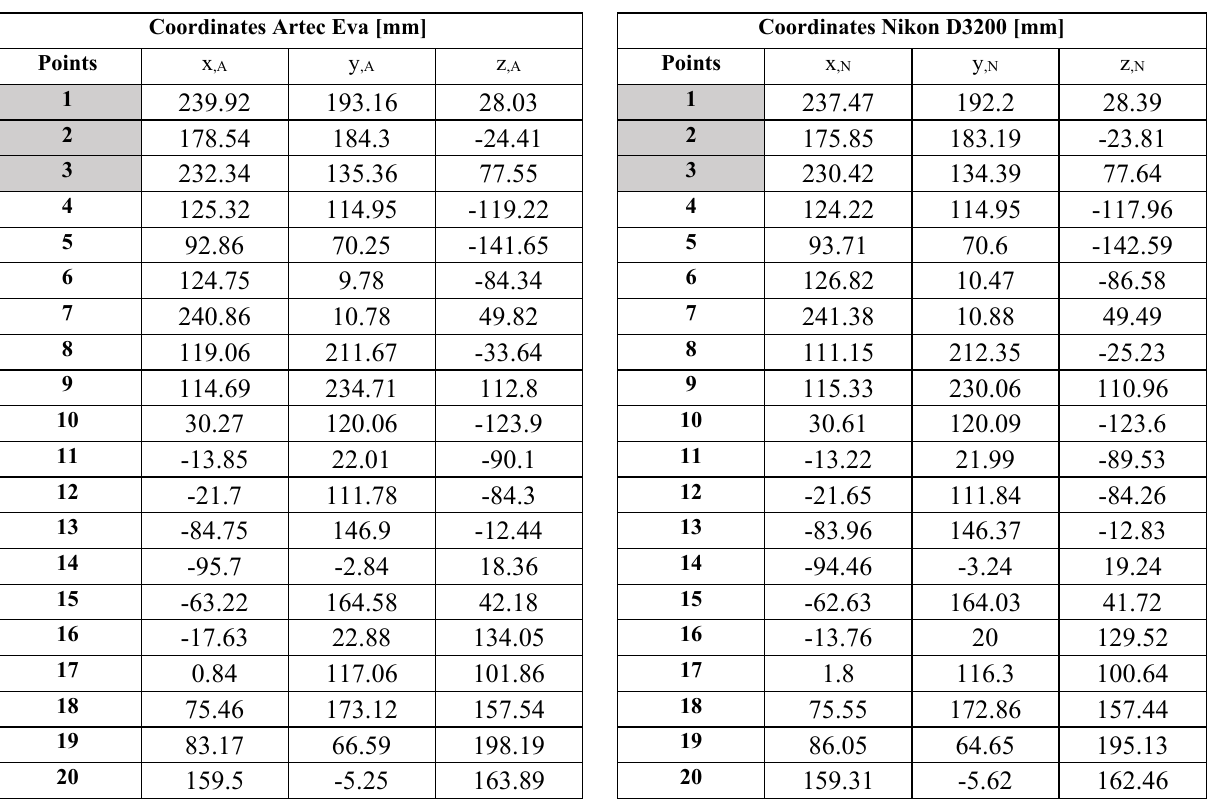
Table 9. Coordinates of the 20 points of Artec Eva model